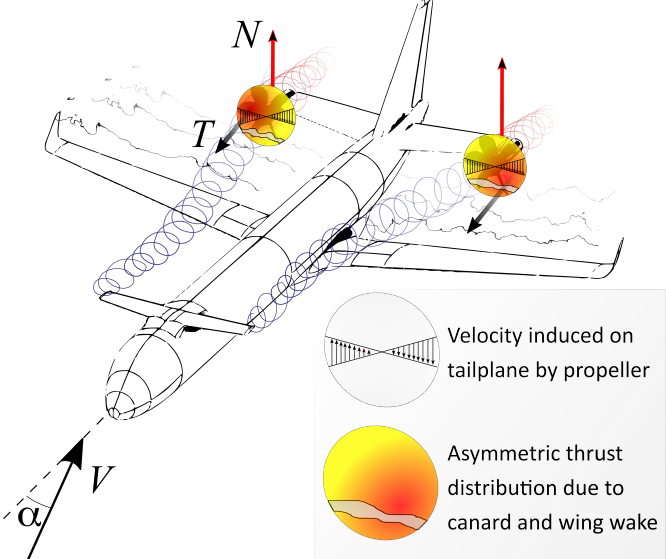
Figure 20. A qualitative sketch of aero-propulsive interactions on the IRON innovative